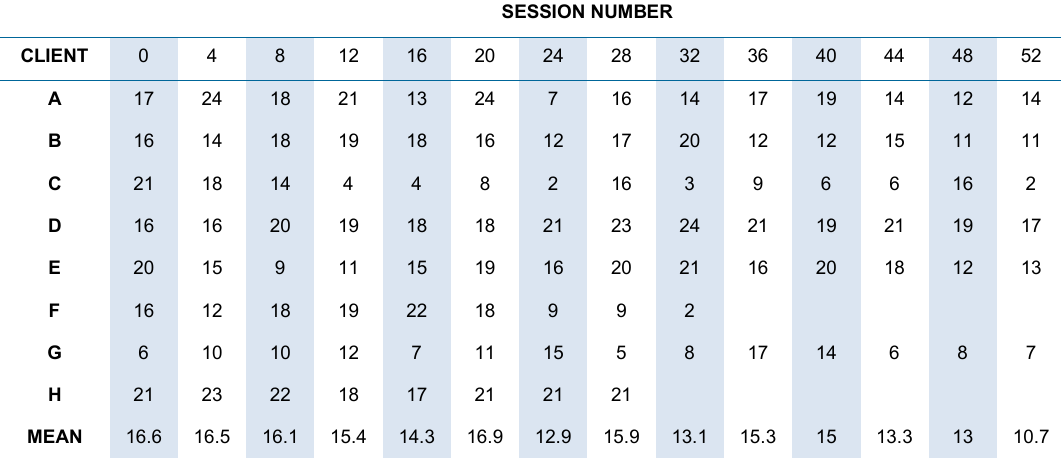
Table 5: Mean PHQ-9 score: 8 long-term clients